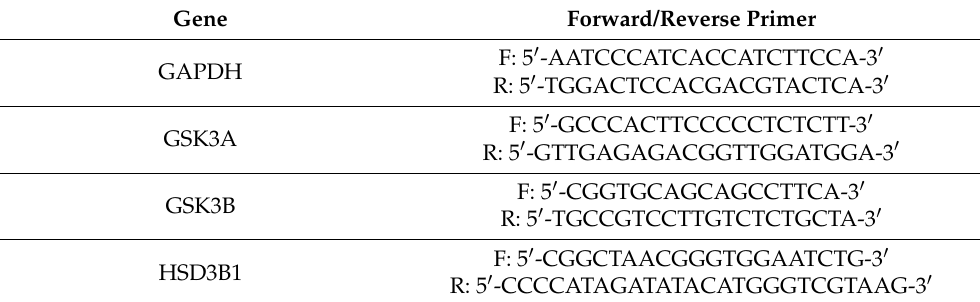
Table 1. Primer sequences for